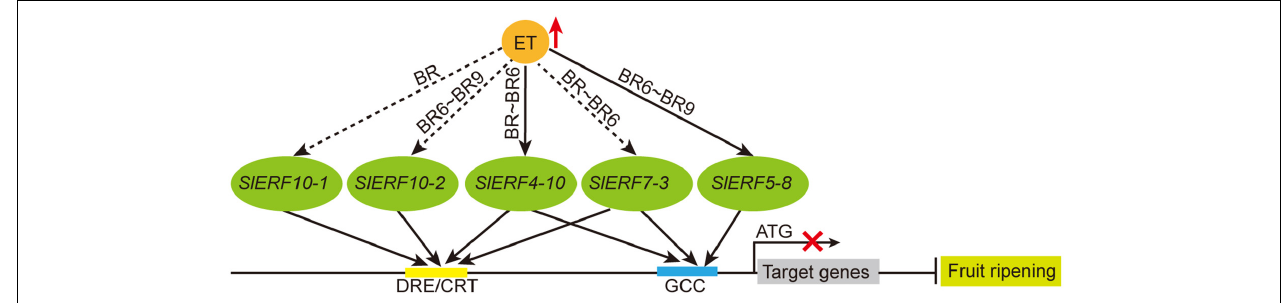
FIGURE 8 | The relationship of ET and EAR motif-containing SlERF genes during tomato fruit ripening. Red upward arrow, indicates increase; black solid arrow between ET and SlERF genes, indicates direct induction; black dashed arrow, indicates indirect induction; black solid arrow between SlERF and DRE/CRT or GCC boxes, indicates interaction; black line ending with bar, indicates repression; red cross, indicates transcriptional